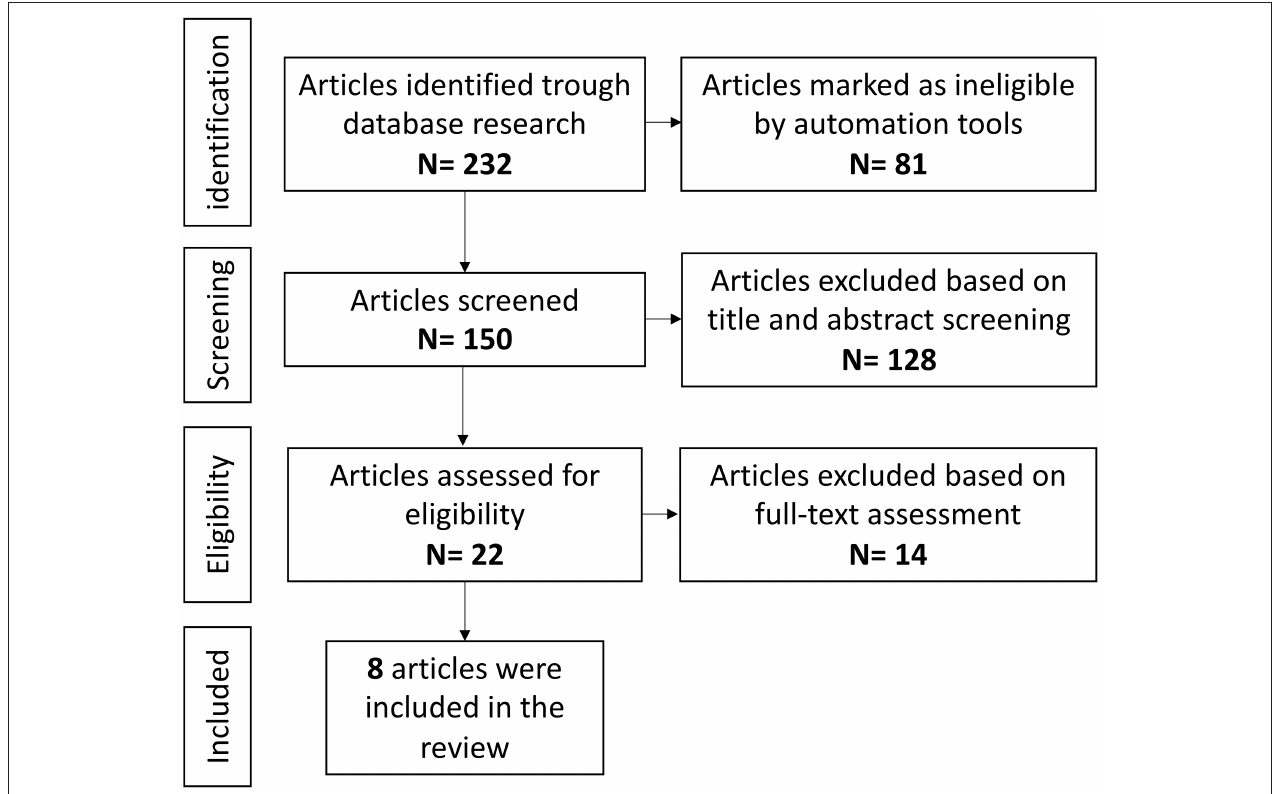
FIGURE 6 | Anti-CD20 agents and epilepsy, literature